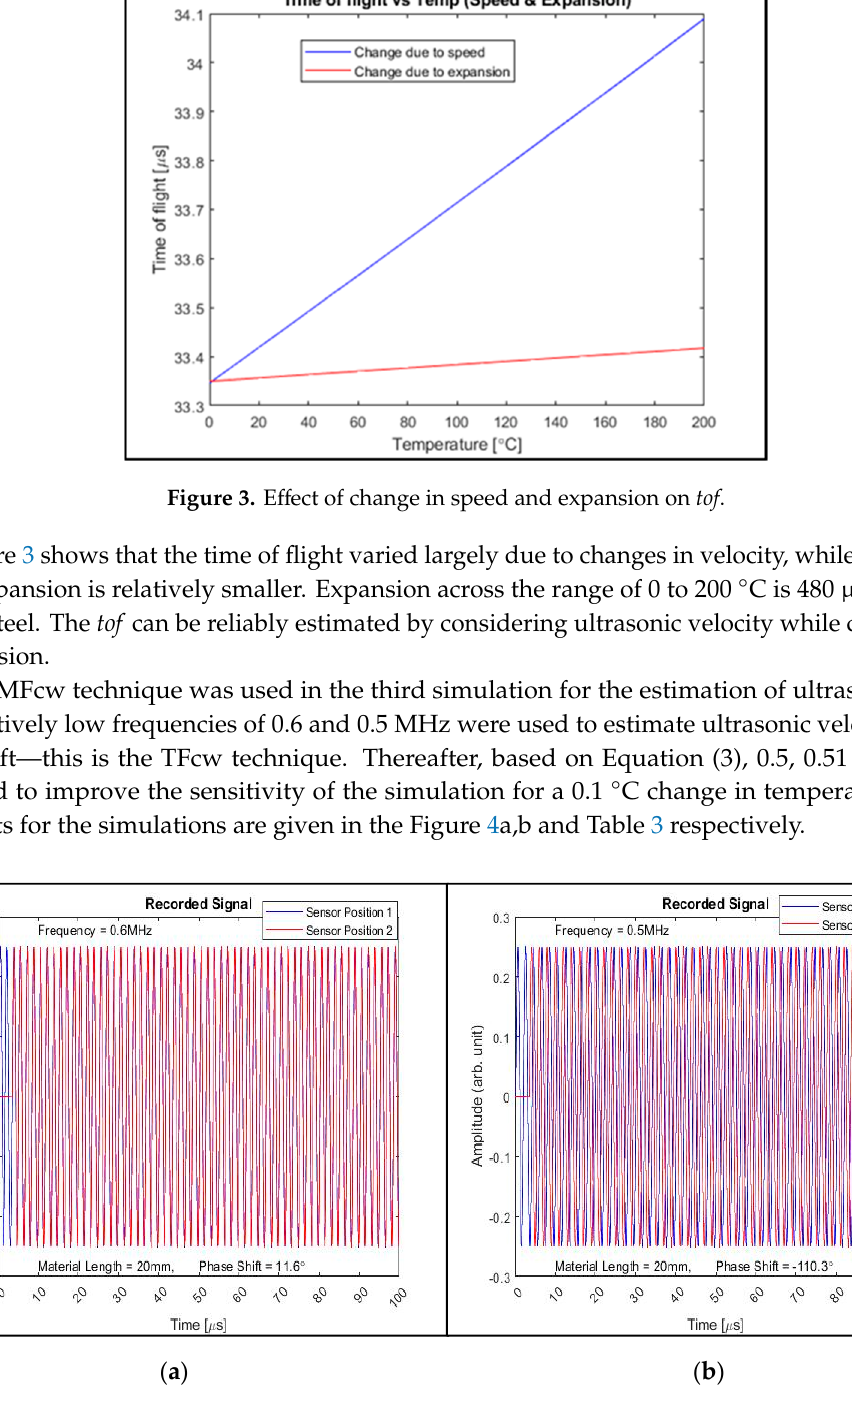
Figure 4. Two-frequency continuous wave method (TFcw) technique ( a ) 11.6 phase-shift at 0.6 MHz; ( b ) − 110.3 phase-shift at 0.5 MHz.